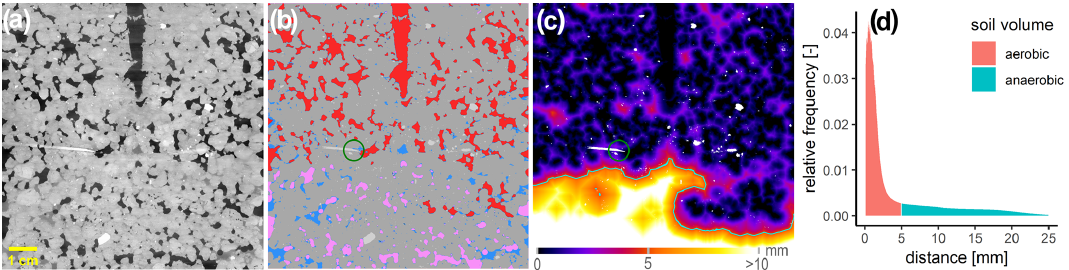
Figure 2. A 2D slice of one soil core packed with large aggregates (4–8mm) from Gießen soil (GI) incubated at 75% WFPS to illustrate grey value contrast between materials. (a) One oxygen microsensor is shown on the left (white needle) and the hole of the temperature sensor at the top (black) within the soil matrix (grey), stones (white), and pores that are filled either with air (black) or water (light grey). (b) Material classes after segmentation including soil matrix (grey), water (blue), mineral grains (light grey), connected air (red), and isolated air (rose). The green circle around the light-grey sensor tip depicts the diameter of 7.2mm that is used to characterize its environment. (c) The 3D Euclidean distance to the closest connected-air voxel (mineral grains are excluded) in each soil matrix or water voxel. The closest air voxel might be outside of the 2D plane. The green line depicts the connected-air distance threshold of 5mm that differentiates between an anaerobic soil volume fraction (light colours) and aerated volume (dark colours). (d) Relative frequency of soil volume as a function of distance to closest connected air [mm] divided into aerobic (red) and anaerobic (green) soil